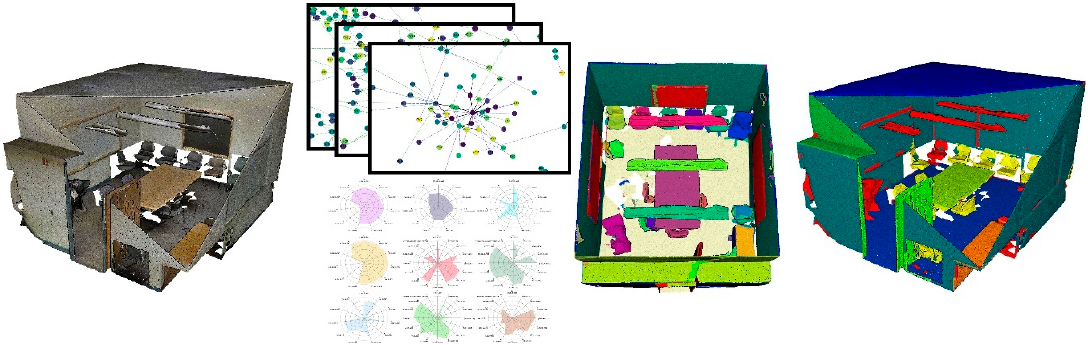
Figure 1. Voxel-based three-dimensional (3D) semantic segmentation. From left to right: Raw point cloud, feature engineering, Connected Elements extraction, Classified point cloud.